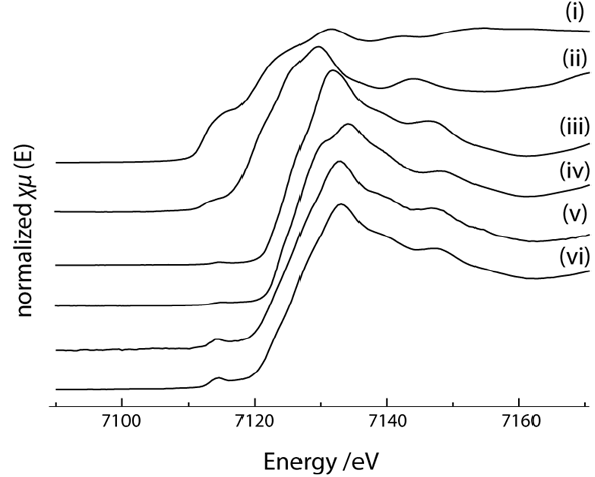
Figure 15. XANES region of the XAS spectra for ( i ) metal Fe foil; ( ii ) ferrous oxide, FeO; ( iii ) magnetite, Fe 3 O 4 ; ( iv ) hematite, Fe 2 O 3 ; ( v ) 0La sample after WGS reaction; ( vi ) 1La sample after WGS reaction. The pre-edge energies for both samples are close to the energy of magnetite.